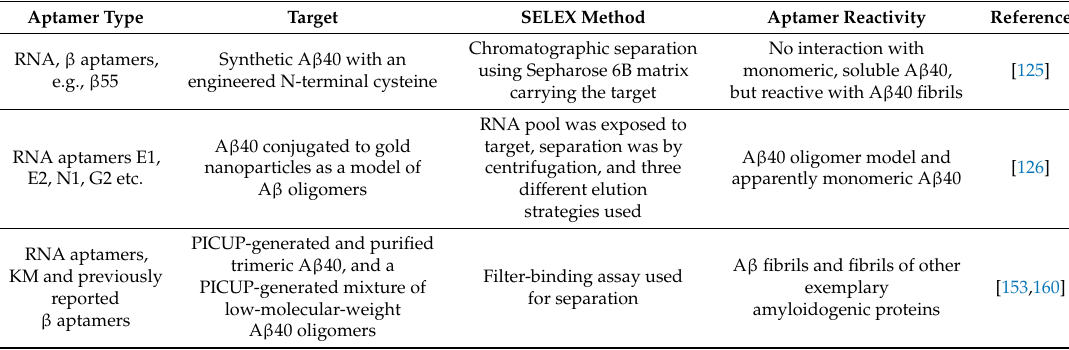
Table 1. Aptamers selected for interacting with different amyloid β -protein (A β ) preparations. Aptamer Type Target SELEX Method Aptamer Reactivity Reference RNA, β aptamers, e.g., β